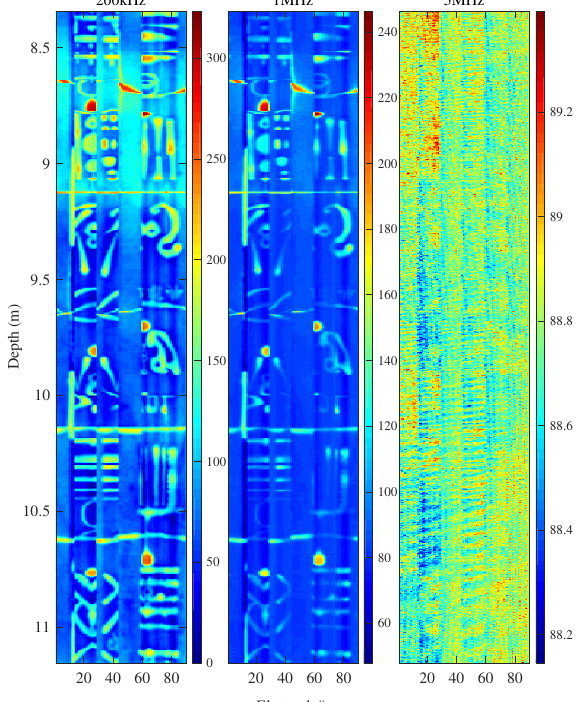
Figure 11. The imaging result of borehole wall patterns with UMMAI sample modulus in the first test, while the borehole is filled with oil-based mud.